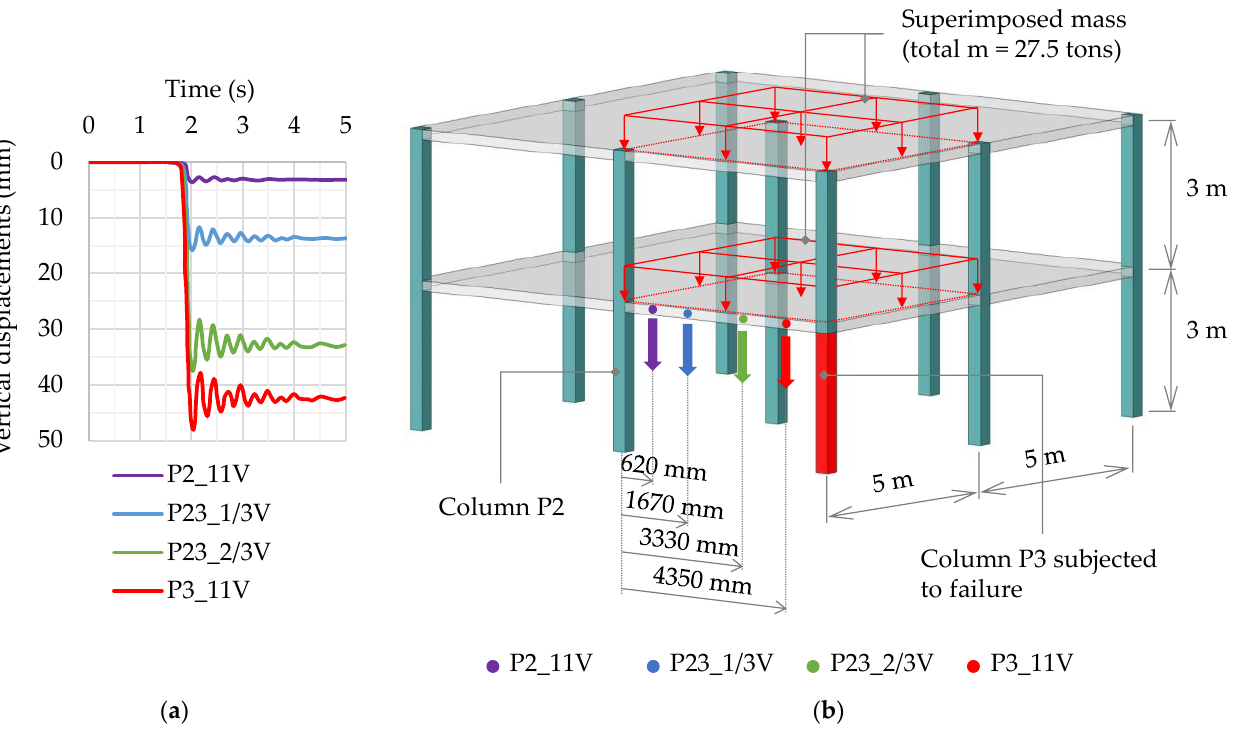
Figure 3. Time history of vertical displacements ( a ) and geometry of the two-story reinforced concrete frame ( b ).